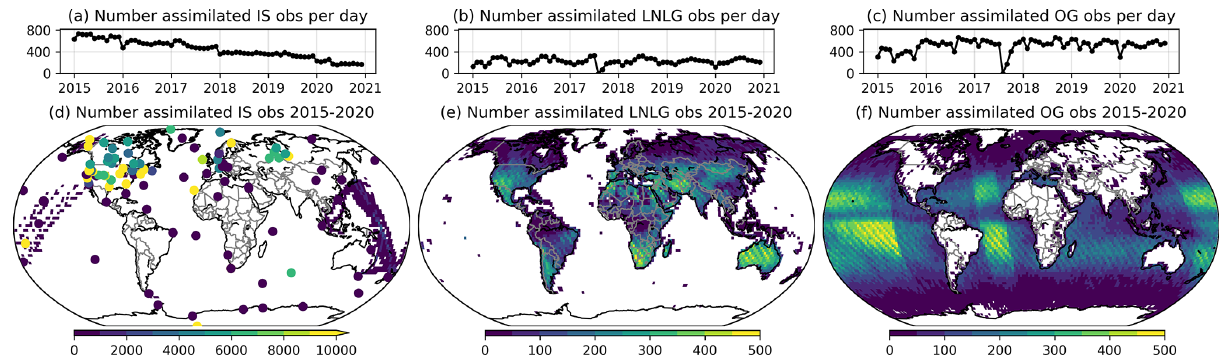
Figure 3. Assimilated observations for IS, LNLG and OG v10 MIP experiments. Number of monthly (a) in situ CO 2 measurements and (b) ACOS v10 OCO-2 land nadir and land glint X CO retrievals binned into 10s averages and (c) ACOS v10 OCO-2 ocean glint X CO 2 2 retrievals and (f) ACOS v10 OCO-2 retrievals binned into 10s averages. Spatial distribution of (d) in situ (e) ACOS v10 OCO-2 land X CO 2 retrievals over 2015–2020. Shipboard and aircraft in situ CO 2 measurements are aggregated to a 2 ◦ × 2 ◦ spatial grid, surface ocean X CO 2 retrievals are shown aggregated to a 2 ◦ × 2 ◦ spatial grid. site measurements are shown as scattered points and ACOS v10 OCO-2 X CO 2 Table 2. In situ CO 2 measurement collections used in the v10 OCO-2 MIP, with the total number of measurements between 6 Septem- ber 2014 and 1 January 2021 and the numbers of measurements assimilated and withheld for cross-validation in the same period. More than 95% of the in situ measurements come from the GLOBALVIEW+ and CO 2 NRT ObsPacks, both of which are publicly available at